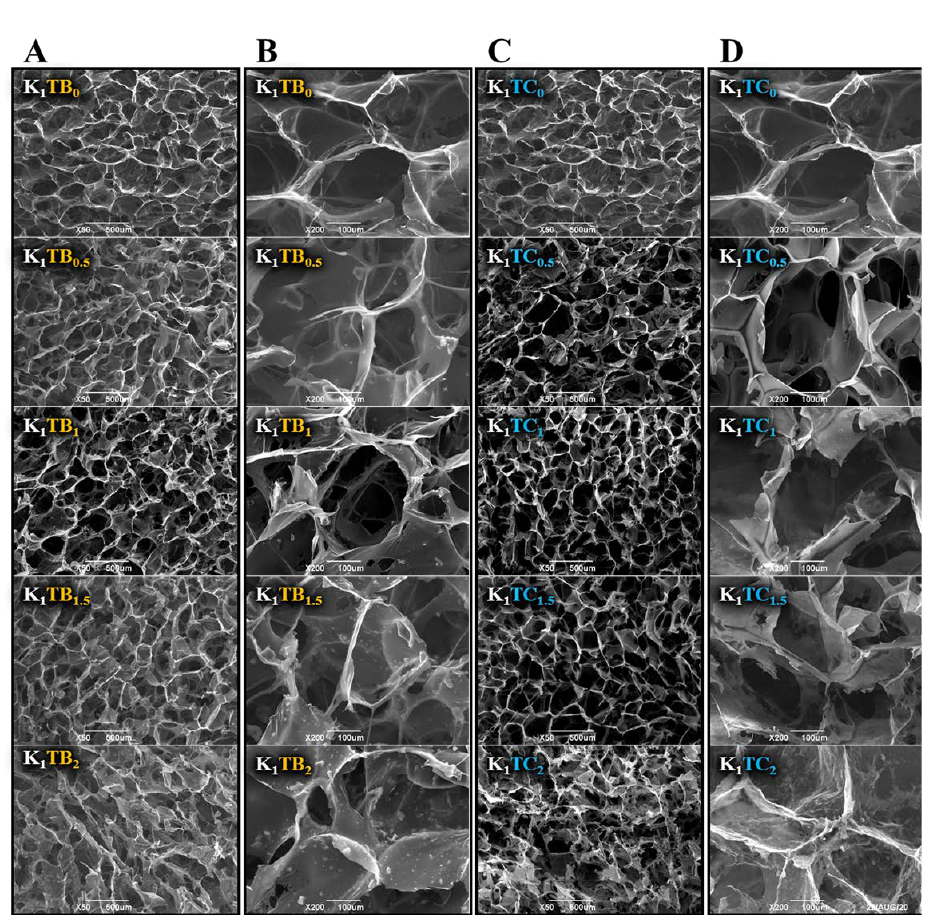
Figure 1. The microscopic morphology of KTB aerogels (( A ) at 50 times; ( B ) at 200 times), and KTC aerogels (( C ) at 50 times; ( D ) at 200 times).